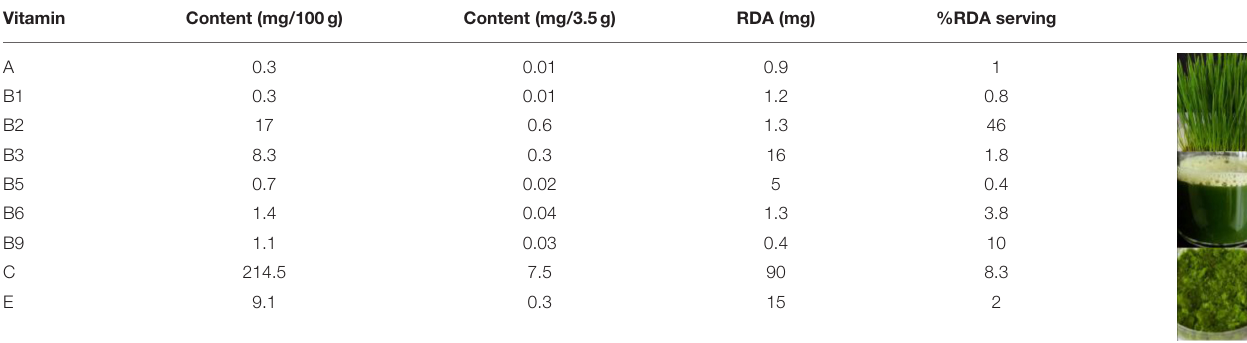
TABLE 3 | Vitamin content present in wheatgrass dehydrated